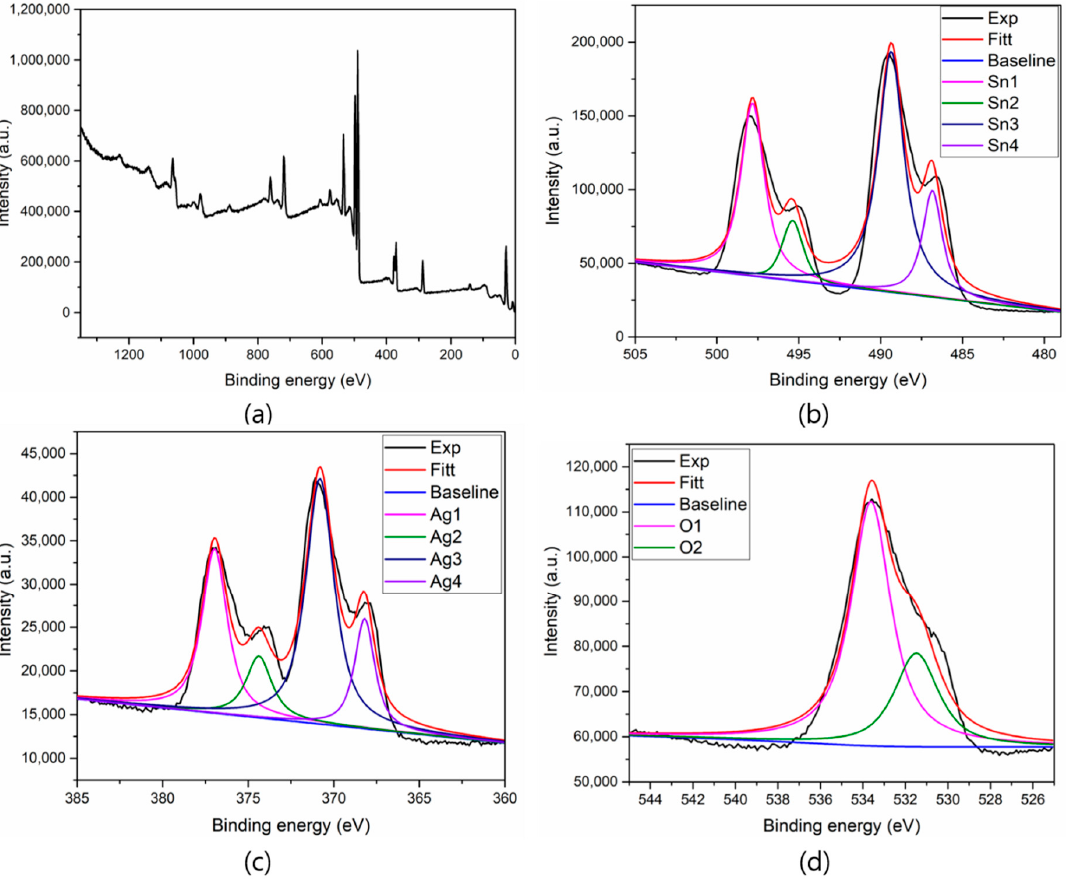
Figure 6. XPS spectra of the SnO 2 and Ag QDs / SnO 2 nanostructures ( a ) Survey scan, ( b ) Tin, ( c ) Silver, and ( d ) Oxygen elements.